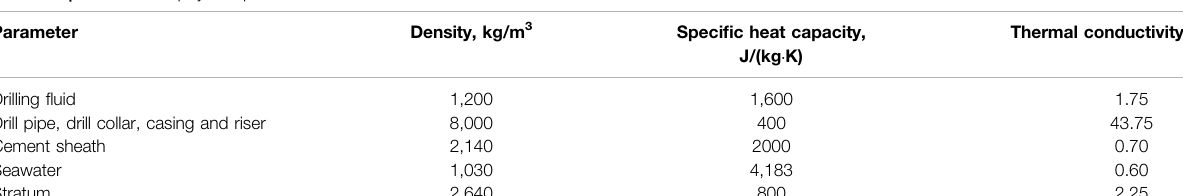
TABLE 3 | Basic thermophysical parameters.